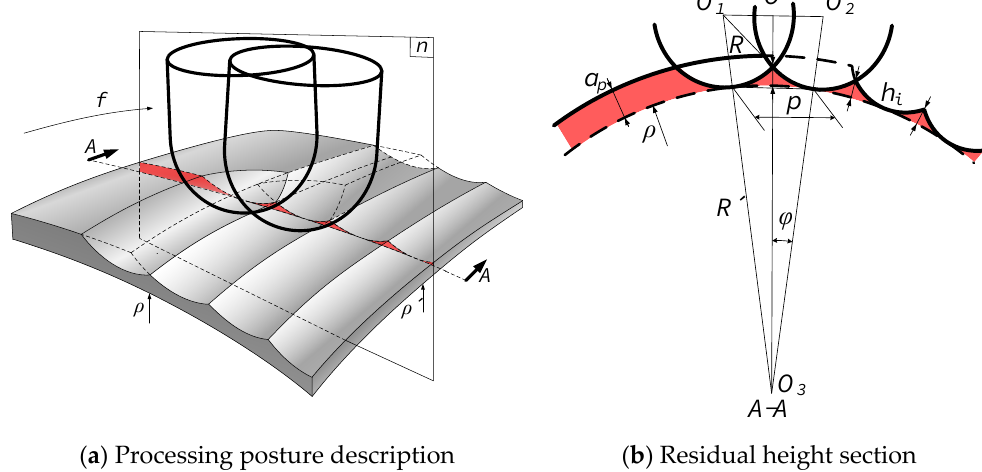
Figure 3. Surface milling residual height diagram.